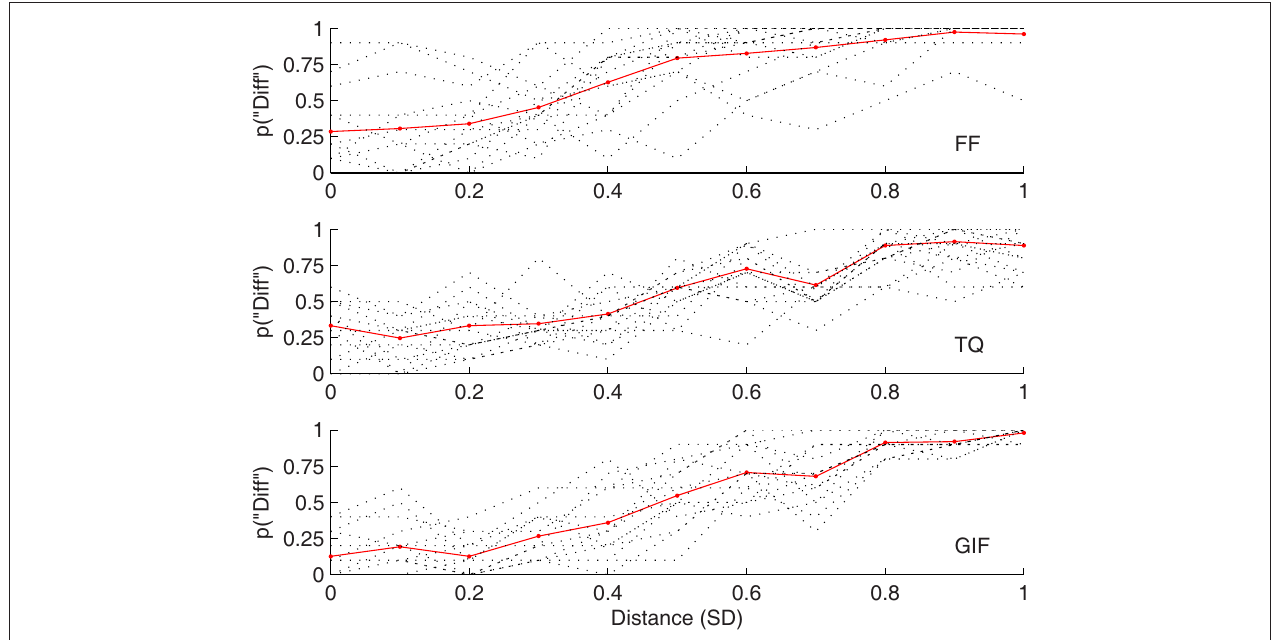
Figure 2 | Proportion “different” responses as a function of physical difference in SD units for the three conditions of experiment 1. Dotted lines indicate individual psychometric functions and solid red lines combined data.